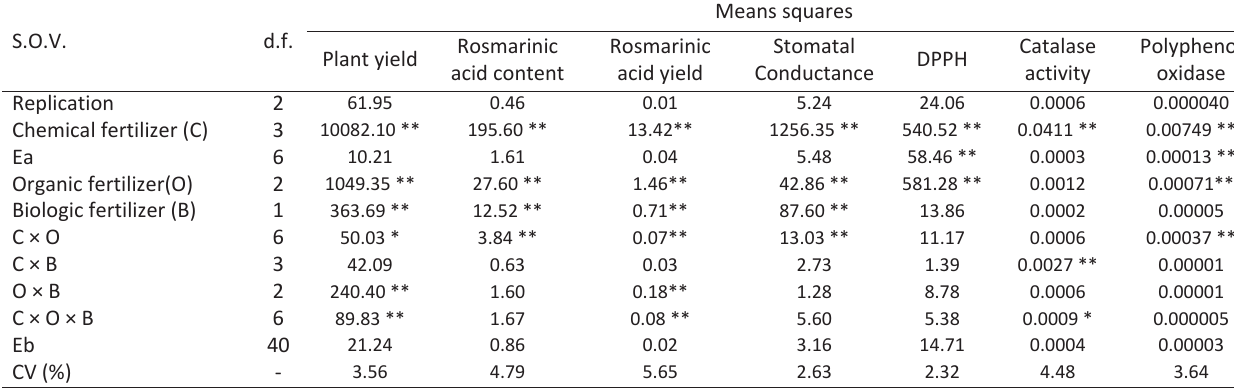
Table 4 - ANOVA of some morphologic, yield and essence traits of Perilla under different fertilizer systems in Mashhad Ardehal in Kashan regions